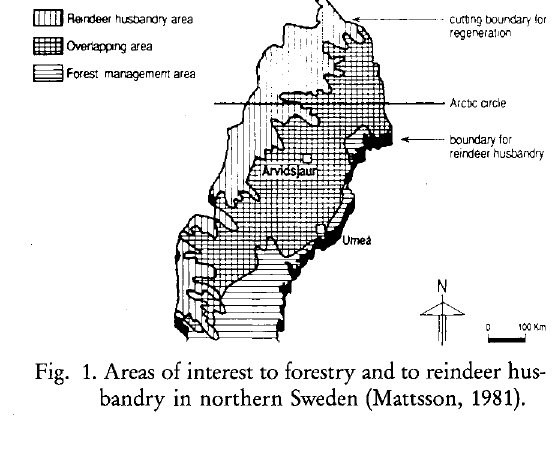
Fig. 1. Areas of interest to forestry and to reindeer hus bandry in northern Sweden (Mattsson,